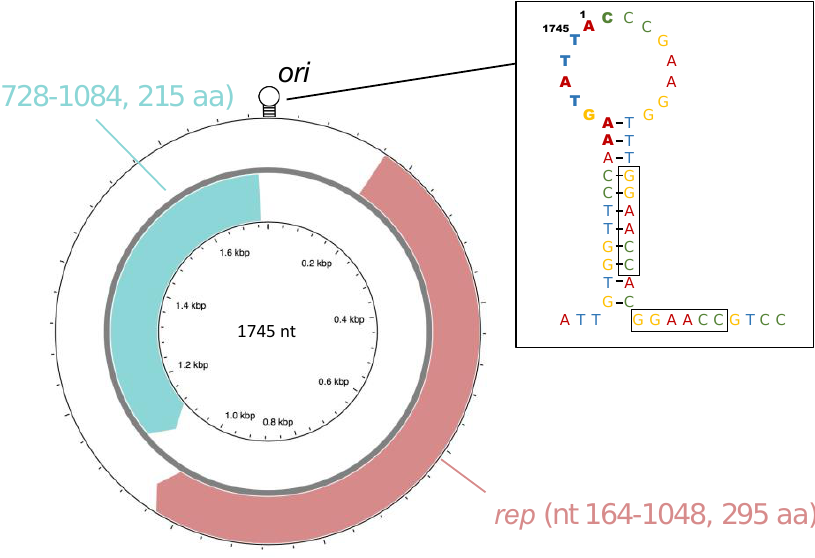
Figure 3. Scheme illustrating the main features of the genome of tawny owl-associated circovirus, generated with CGView Server [33], complemented with a representation of the stem-loop structure. The nonanucleotide constituting the origin of replication ( ori ) is represented in bold, while the tandemly repeated hexamers are boxed.